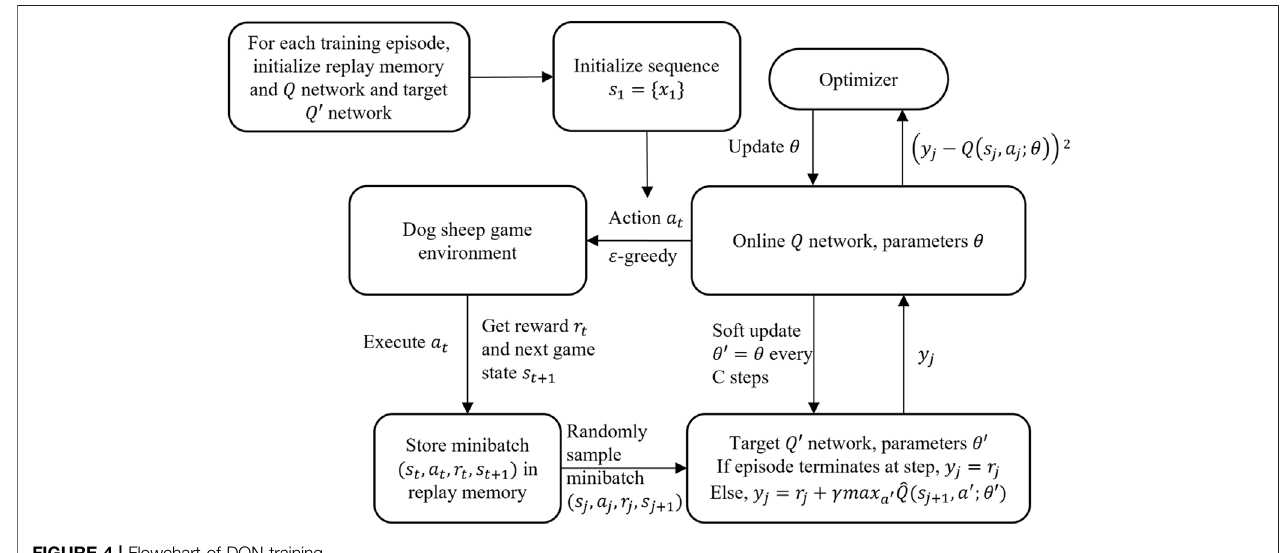
FIGURE 4 | Flowchart of DQN training.